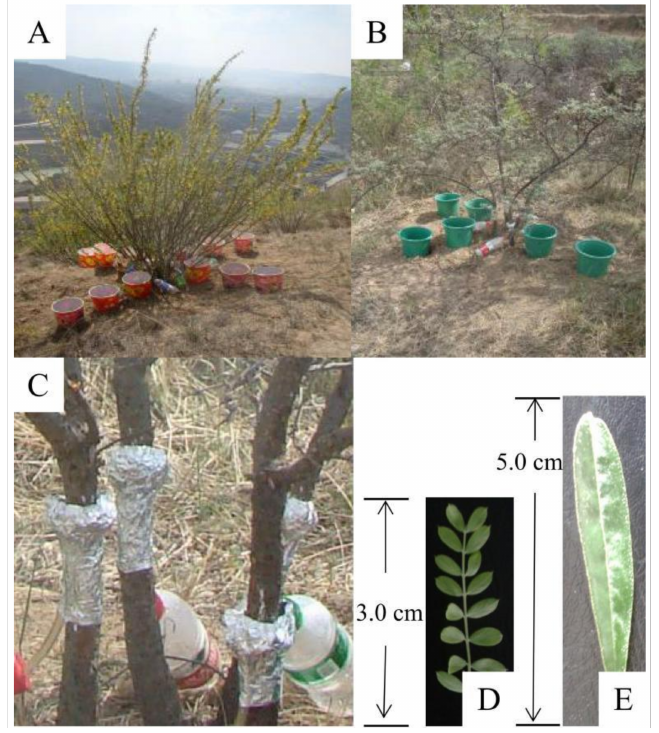
Figure 1. Schematic diagram. ( A ) C. korshinskii ; ( B ) H. rhamnoides ; and ( C ) stemflow collection. ( D , E ) are the leaf characteristics of the two shrubs.